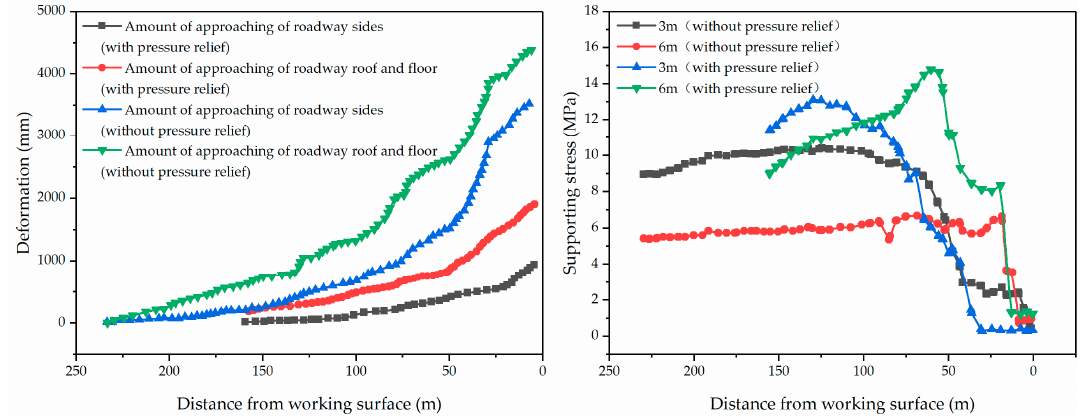
Figure 10. Field observation results.